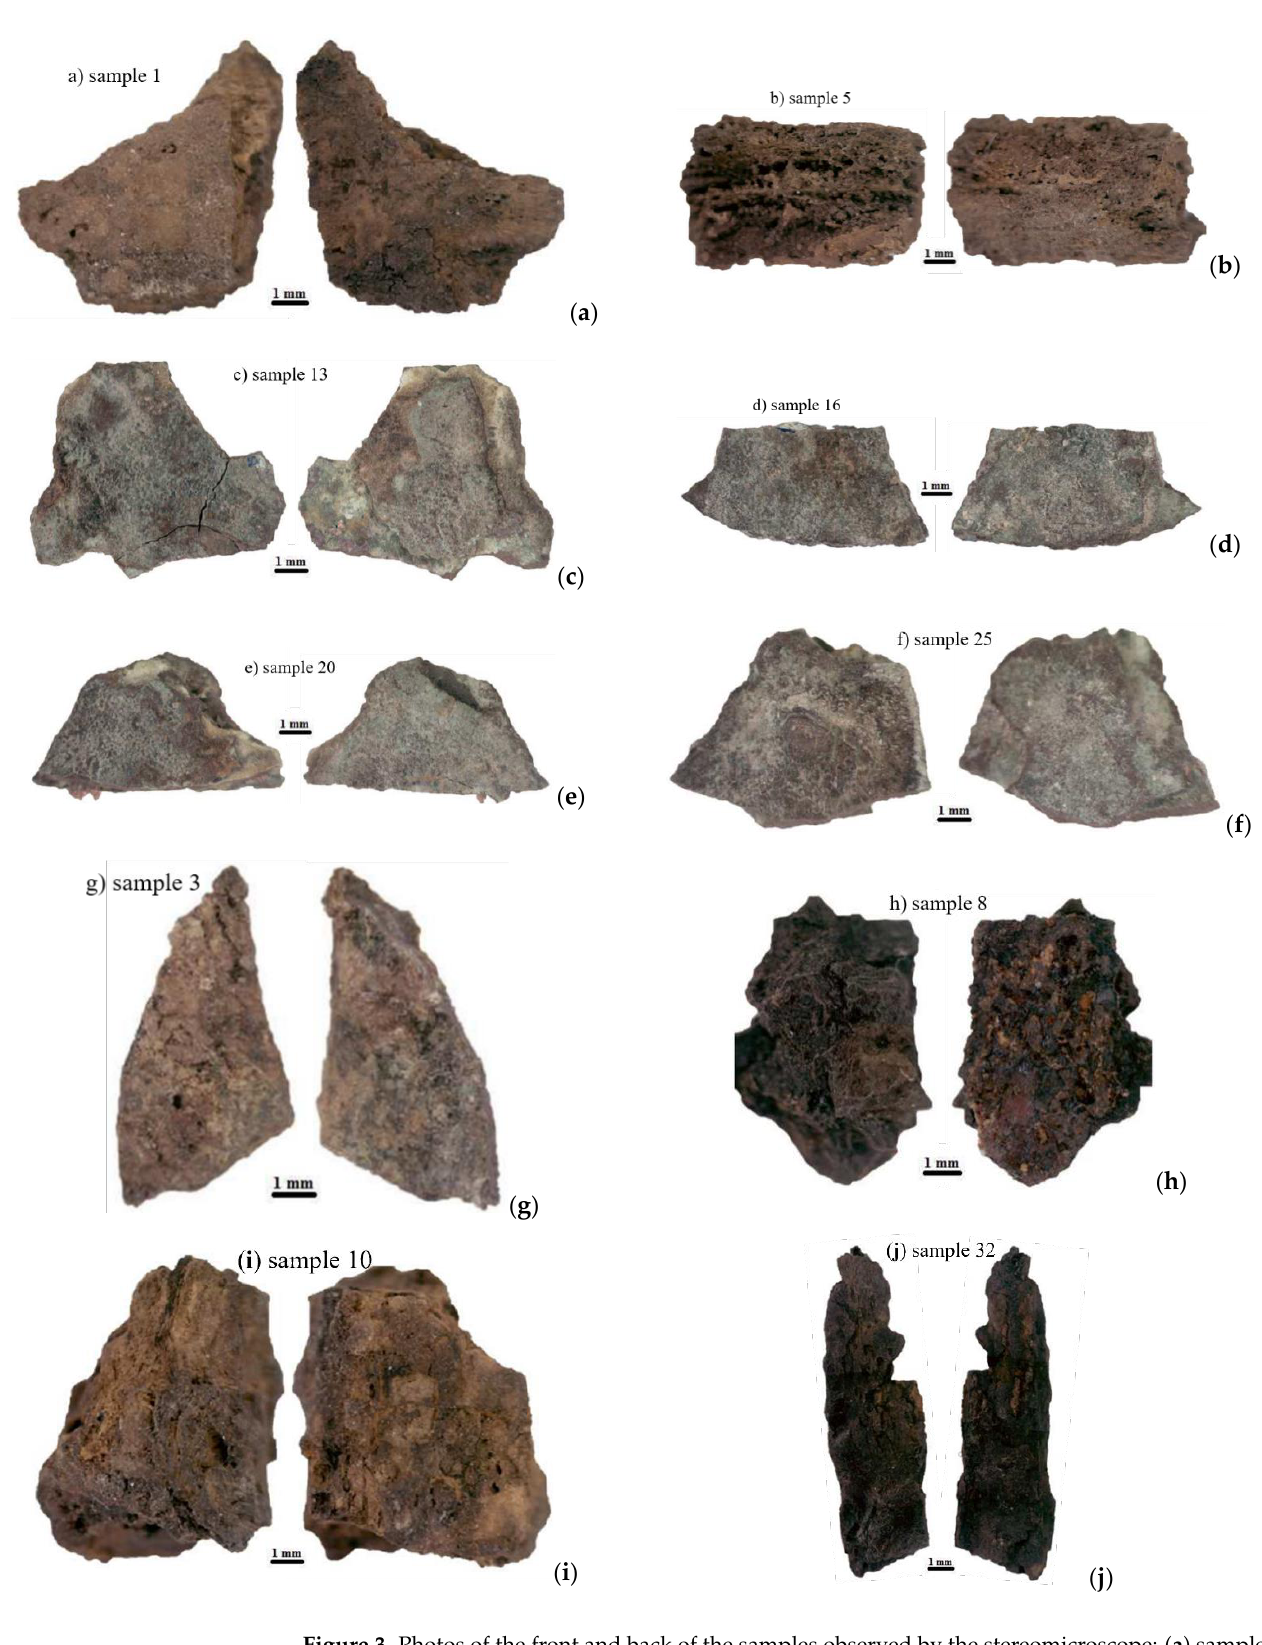
Figure 3. Photos of the front and back of the samples observed by the stereomicroscope: ( a ) sample 1; ( b ) sample 5; ( c ) sample 13; ( d ) sample 16; ( e ) sample 20; ( f ) sample 25; ( g ) sample 3; ( h ) sample 8; ( i ) sample 10; ( j ) sample 32.